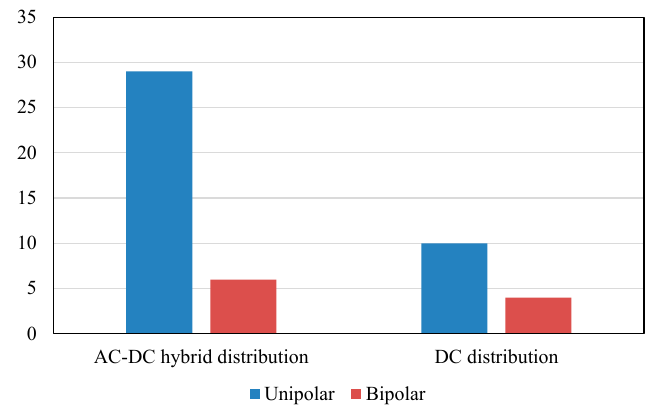
Figure 8. Selection of power distribution system.